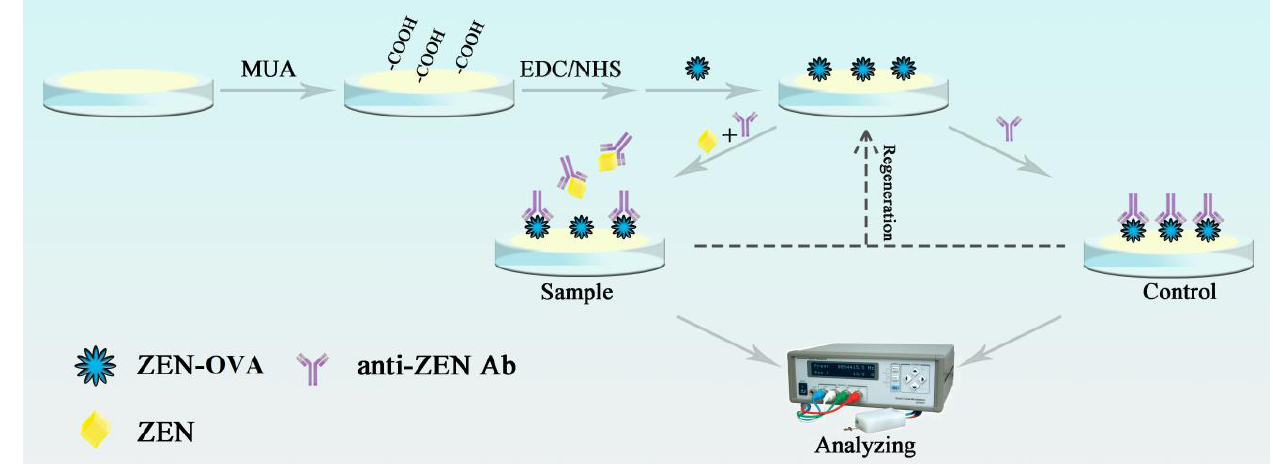
Figure 1. The functionalization and detection process of the developed QCM immunochip.